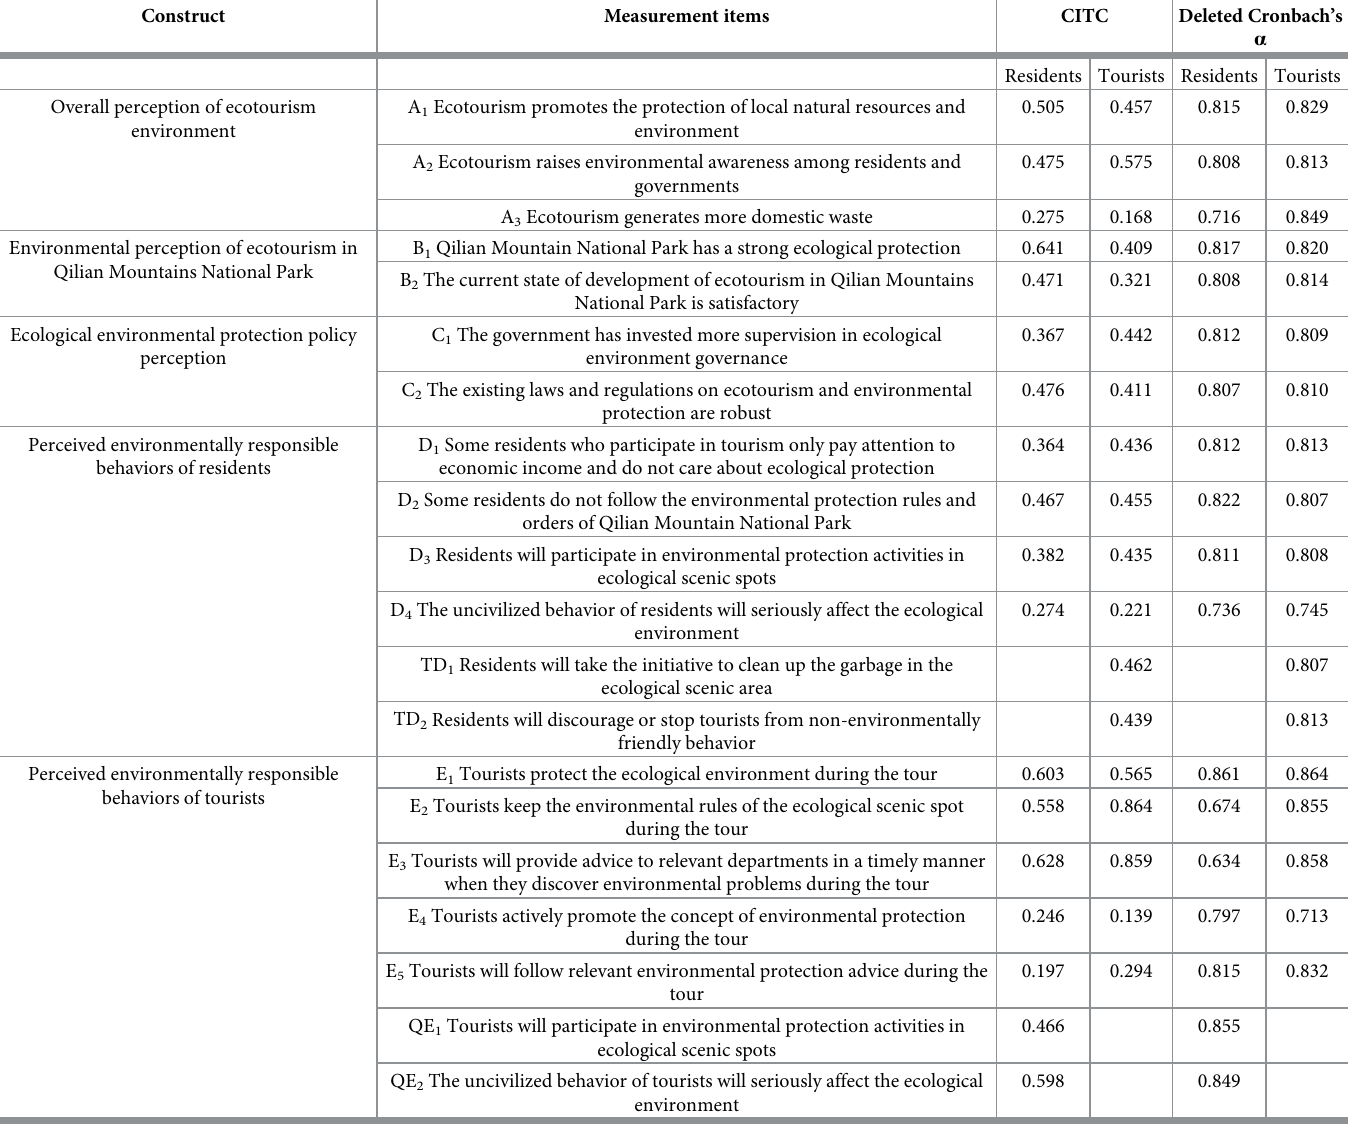
Table 2. Questionnaire reliability test results for residents and tourists.